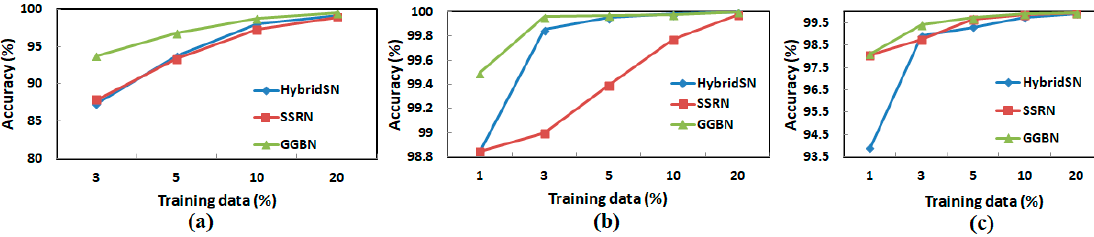
Figure 12. Overall accuracy (OA) in percentage under different numbers of training data ( a ) IP, ( b ), SA, and ( c ) UP.